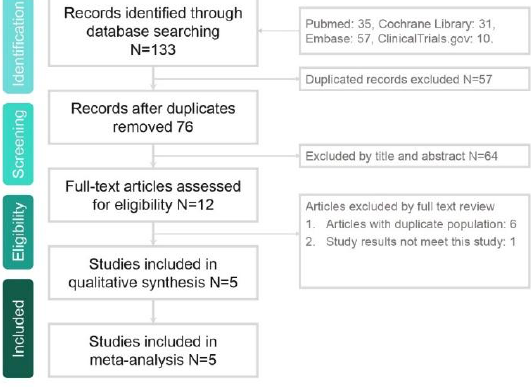
Figure 1. Flowchart of the study selection process.